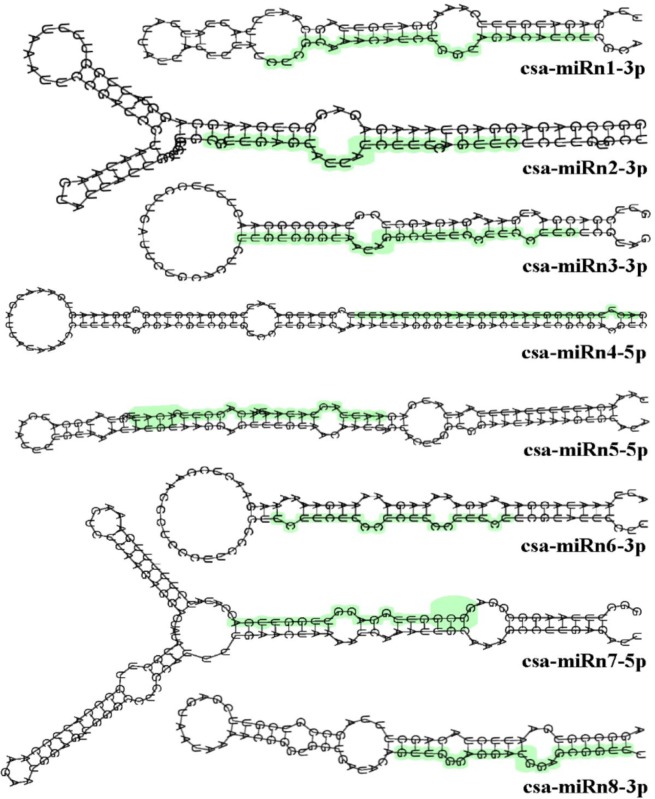
Secondary structure of novel cucumber miRNAs predicted by bioinformatic analysis using RNAfold software (http://rna.tbi.univie.ac.at/cgi-bin/RNAfold.cgi).